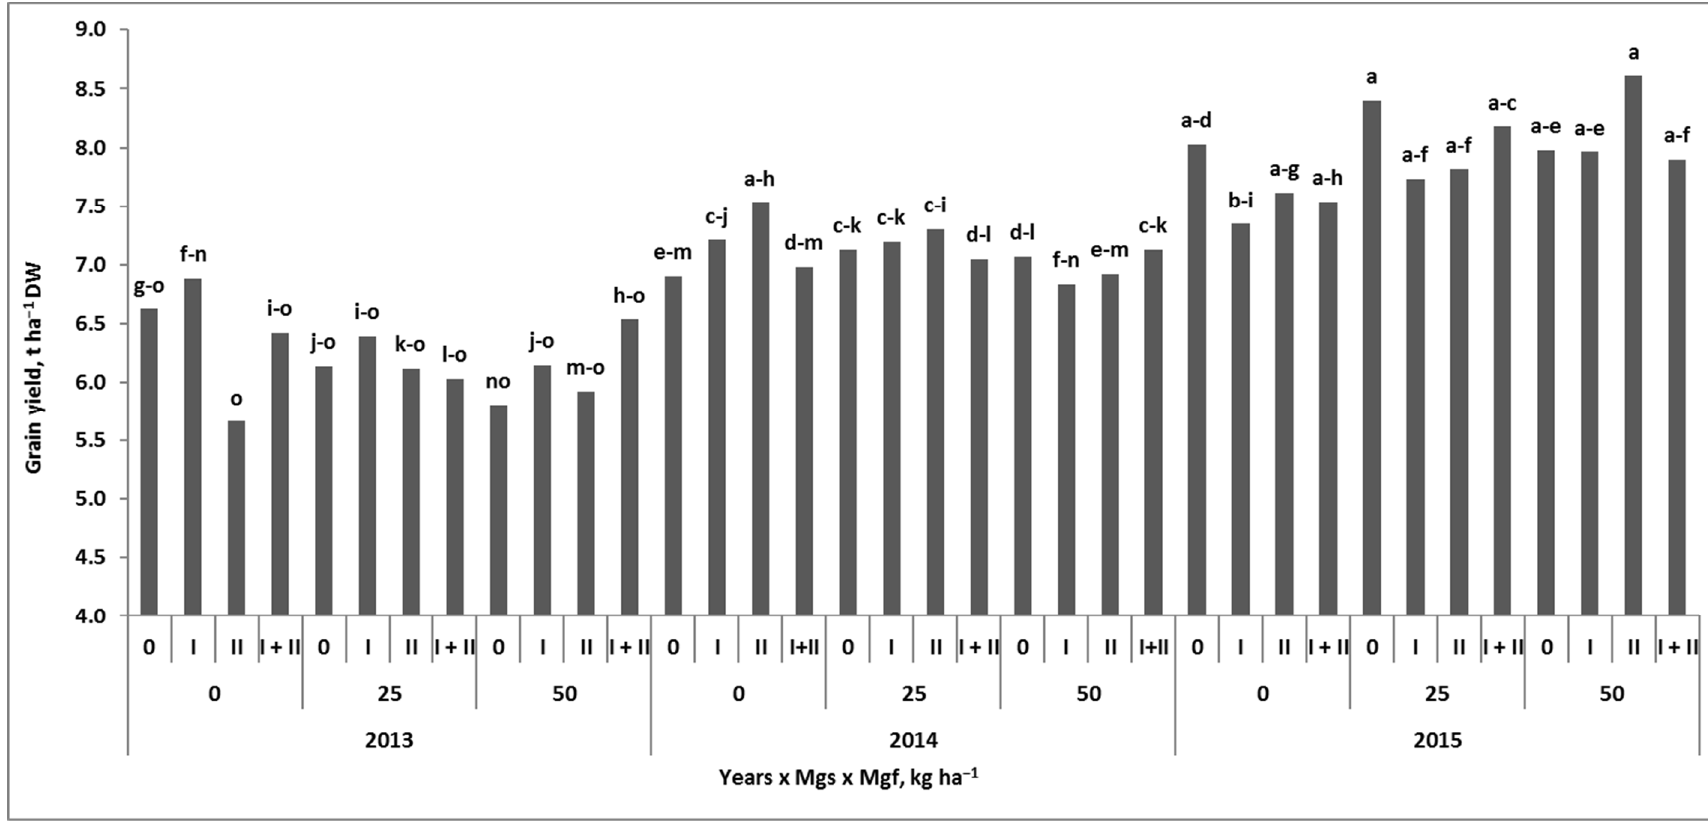
Figure 4. Effect of magnesium fertilization systems on the background of years on the temporary grain yield of winter wheat at the BBCH 79 stage. Similar letters mean a lack of significant differences using Tukey’s test. Legend: Mgs, Mgf—soil and foliar Mg fertilization systems, respectively; I—BBCH 30; II—BBCH 49/50.